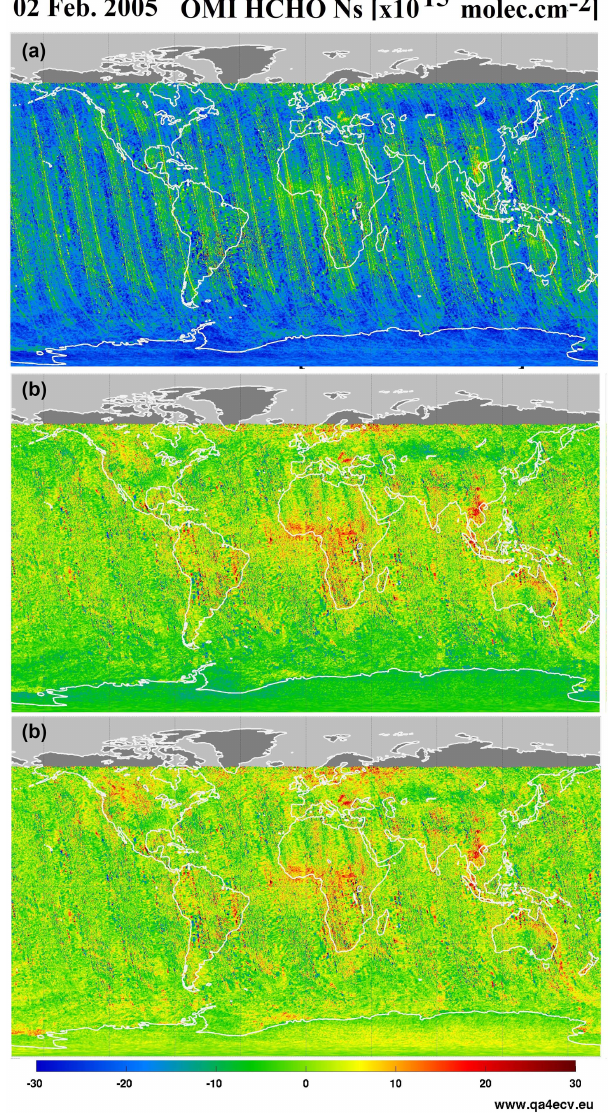
Figure 8. Illustration of the across-track and zonal reference sec- tor correction steps applied to 1 day of OMI HCHO slant columns (2 February 2005). Panel (a) shows the uncorrected slant columns obtained using as DOAS reference spectrum the solar irradiance. Panel (b) shows the same slant columns after the first across-track correction step or when row averaged radiances selected in the Pa- cific Ocean are used as reference. Panel (c) shows the final back- ground corrected slant columns (cid:49)N s